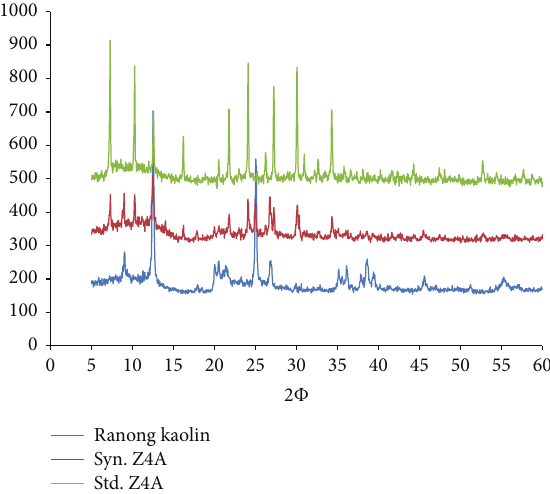
Figure 3: X-ray diffraction patterns of clay and zeolite-4A.